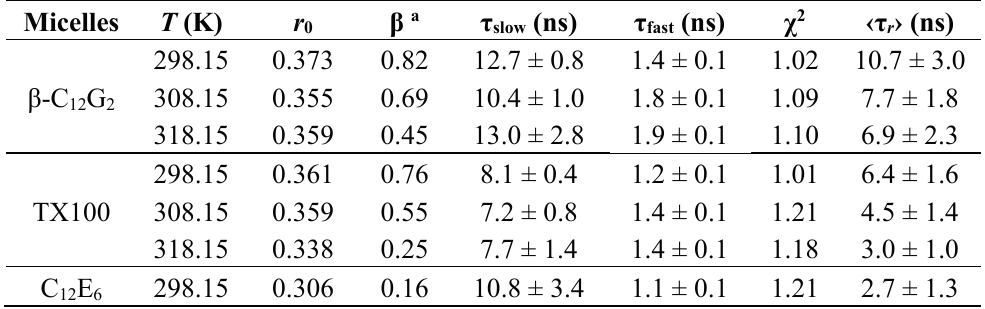
Table 2. Rotational-relaxation parameters for C6 in nonionic micellar systems at different